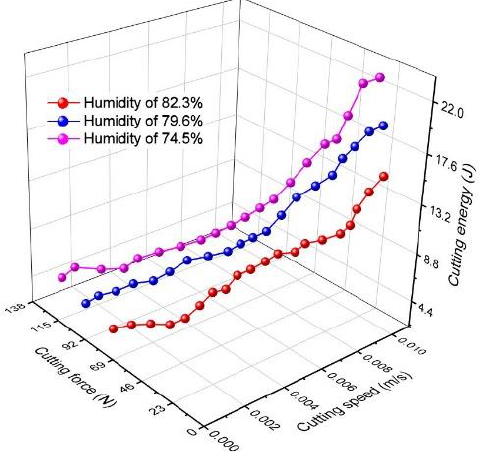
Figure 5. Variation in cutting energy for unpeeled potatoes with different humidity levels as a function of cutting speed.